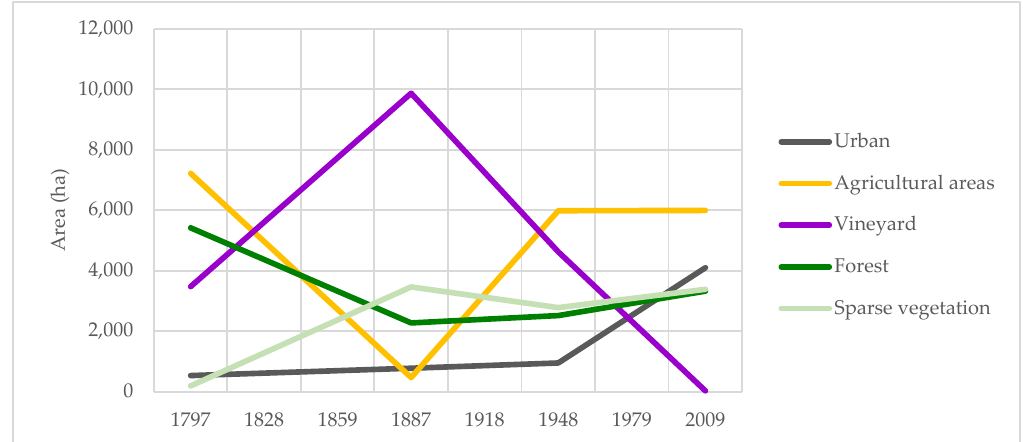
Figure 7. Trends of land use classes in terms of area on the 1817–1907–1960–2009 maps. Regarding LU trend analysis in urban/peri-urban areas (Figure 8), the comparison was performed by considering each time step map in relation to the year 2009 and each time step map in relation to the subsequent one.